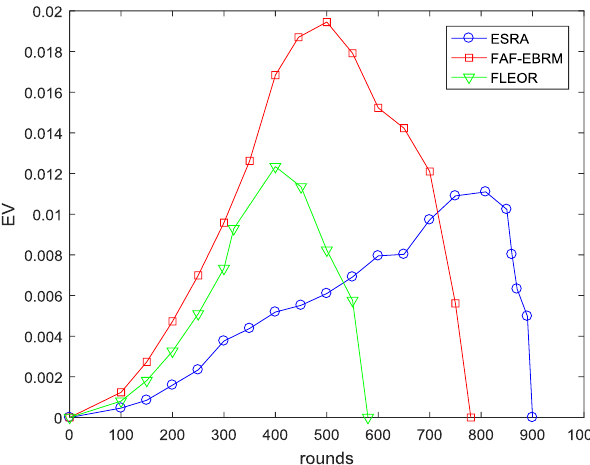
Figure 10. The EV comparisons with varying rounds.